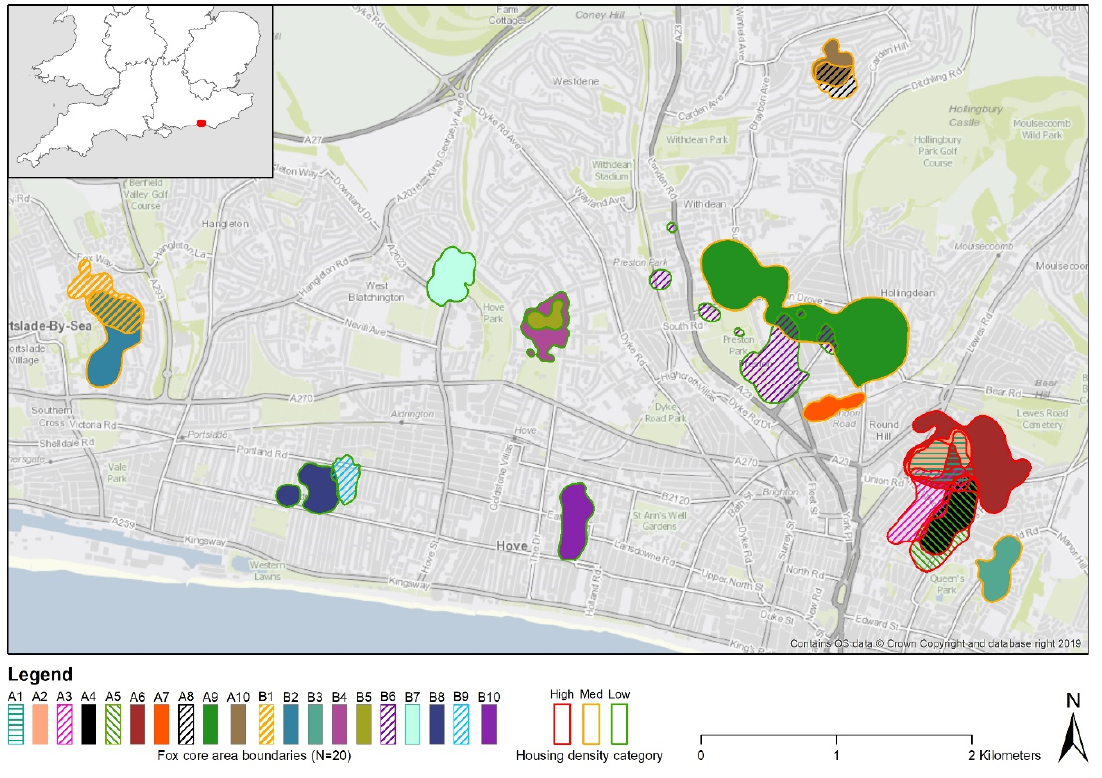
Figure 1. Location of fox core area ranges in six residential zones of the city of Brighton and Hove distributed across each of high, medium, and low housing density areas (low < 30; medium = 30–60; high > 60 usual resident households per hectare).